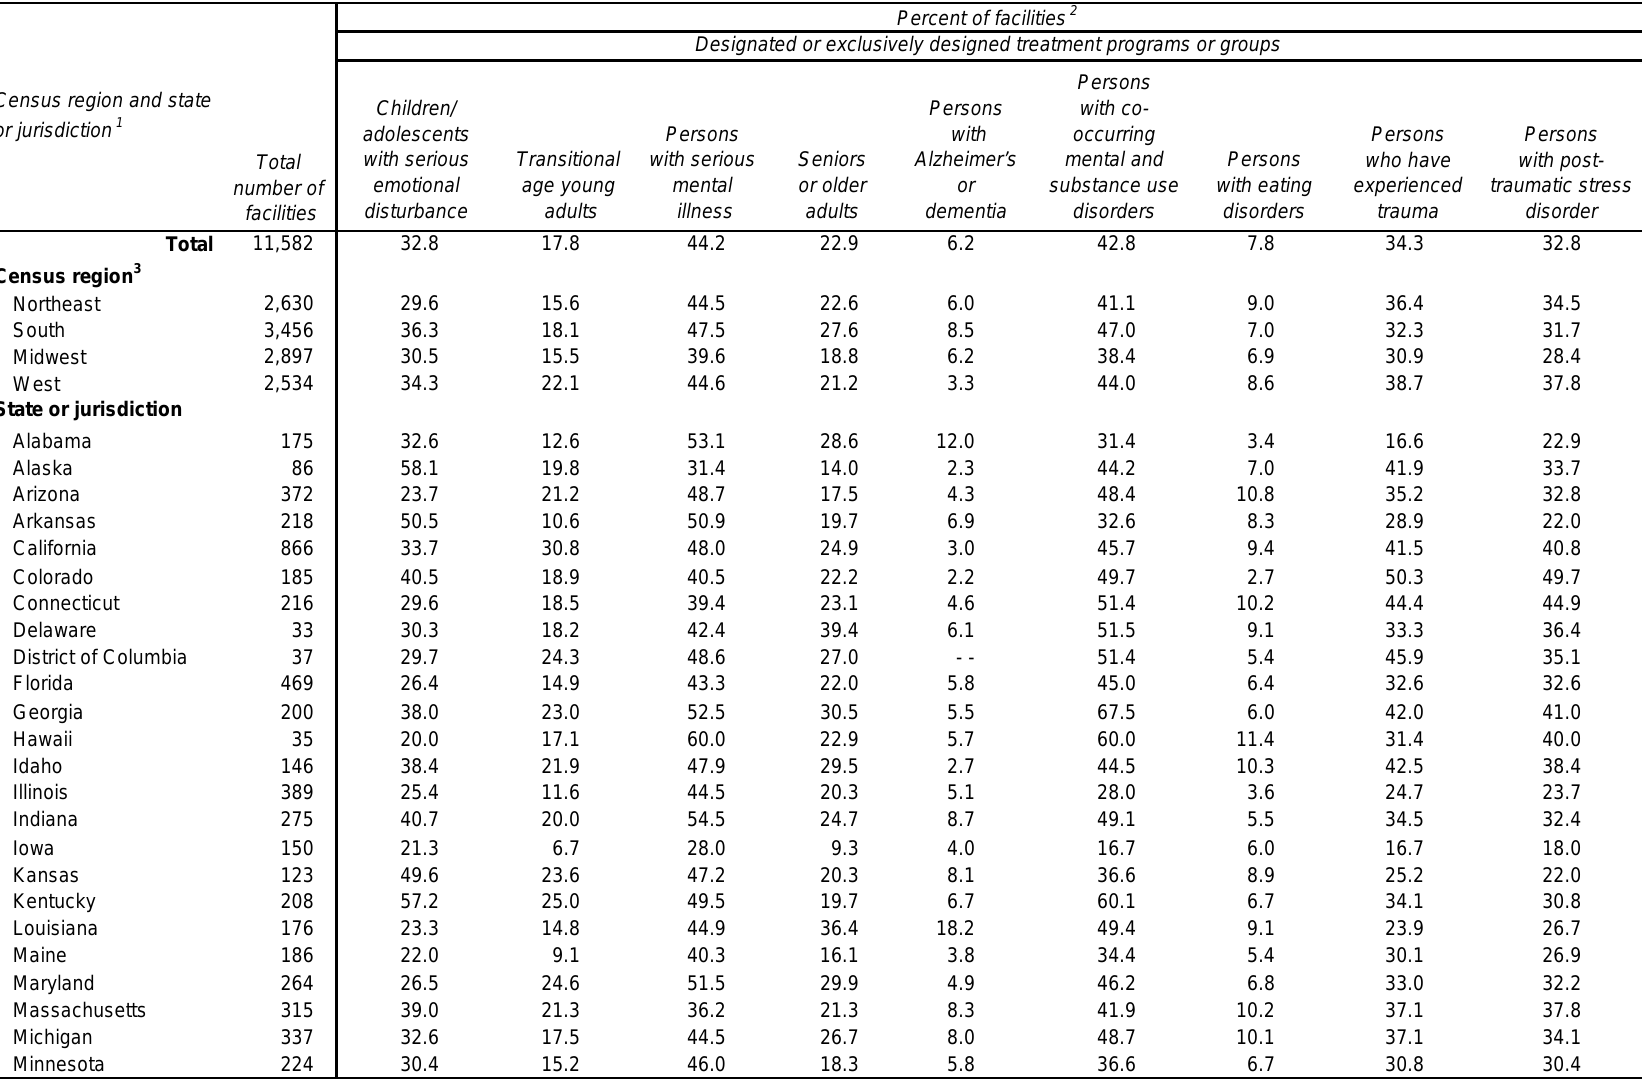
Table 3.10b. Mental health treatment facilities offering treatment programs or groups designated or designed exclusively for specific client categories,